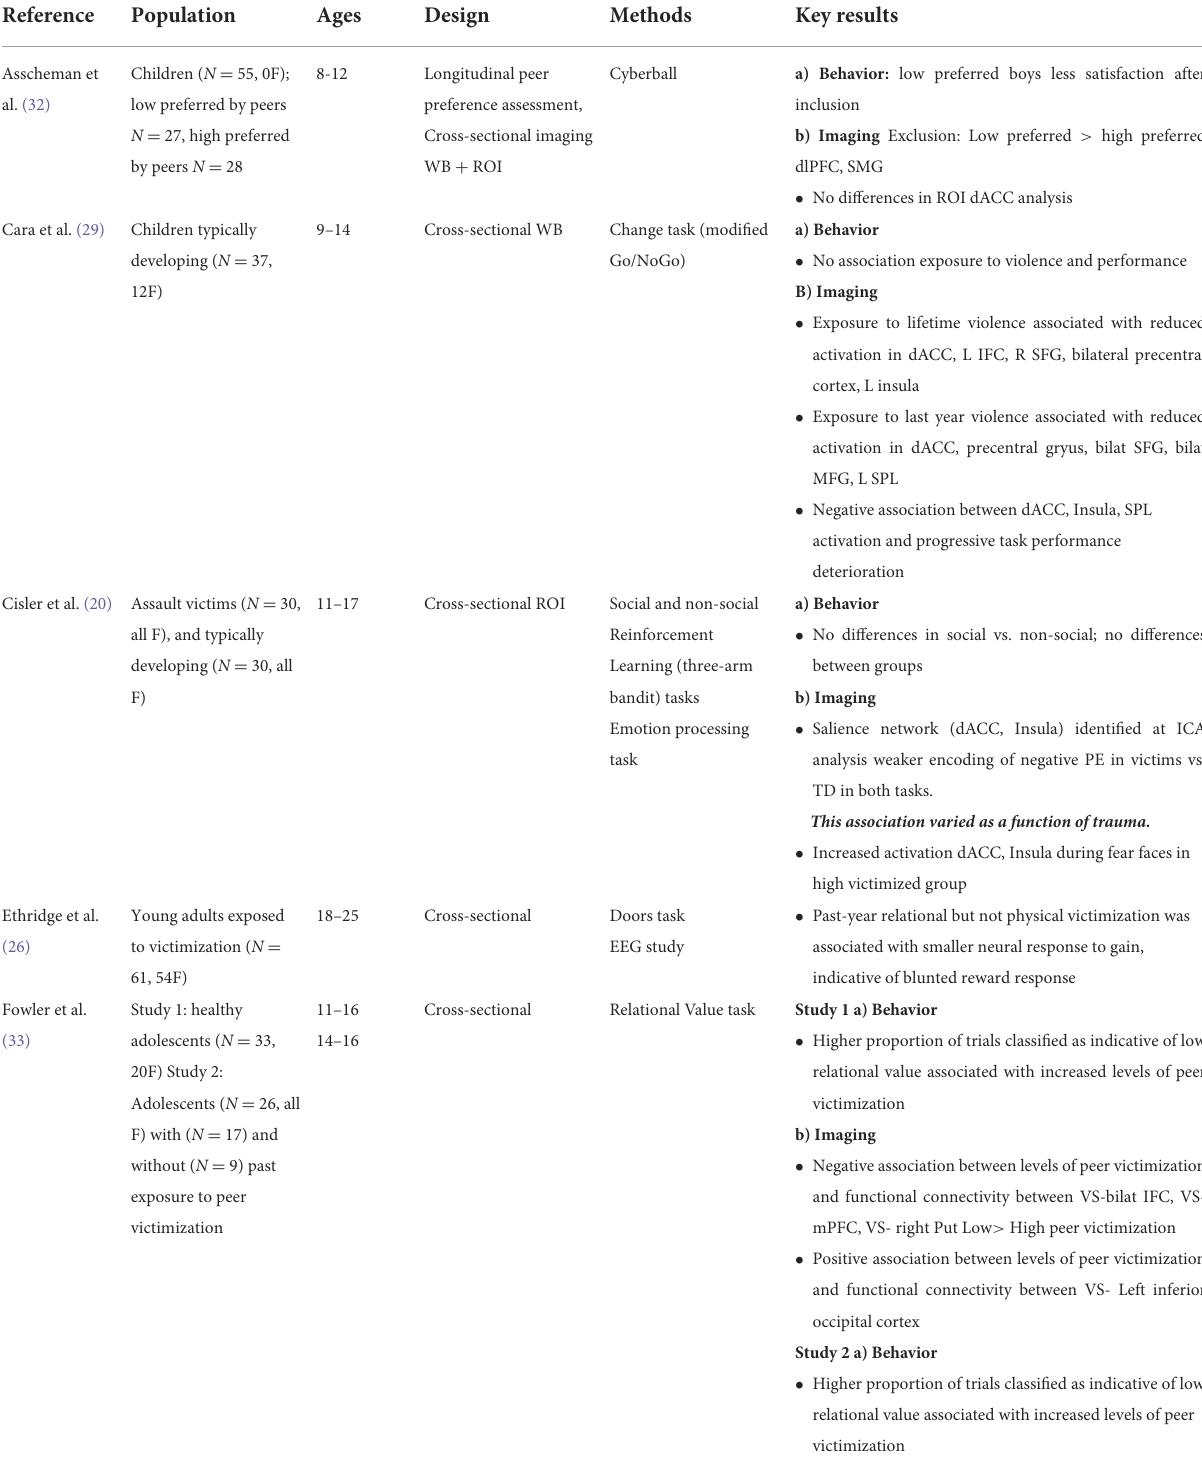
TABLE 1 Summary of main findings of studies on peer victimization combining brain imaging techniques and behavioral paradigms on social, emotional and cognitive control processes.